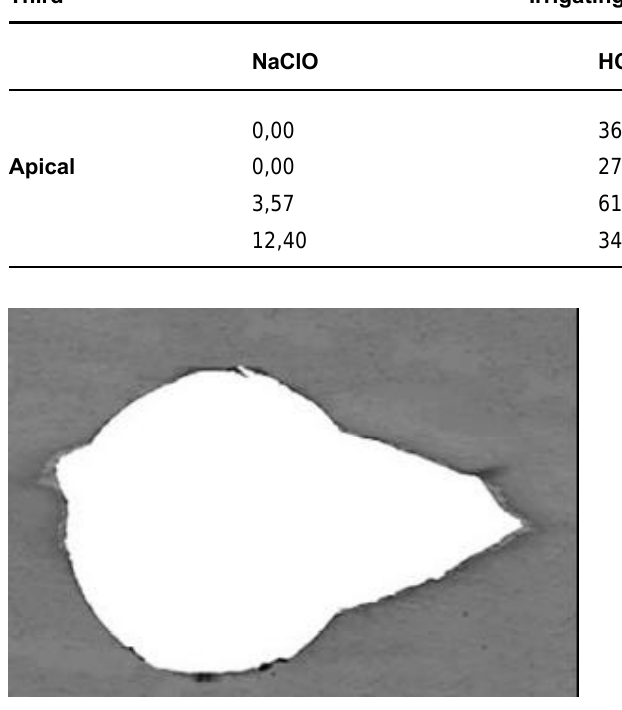
FIGURE 2- Slide showing a root canal from group 2, with the presence of